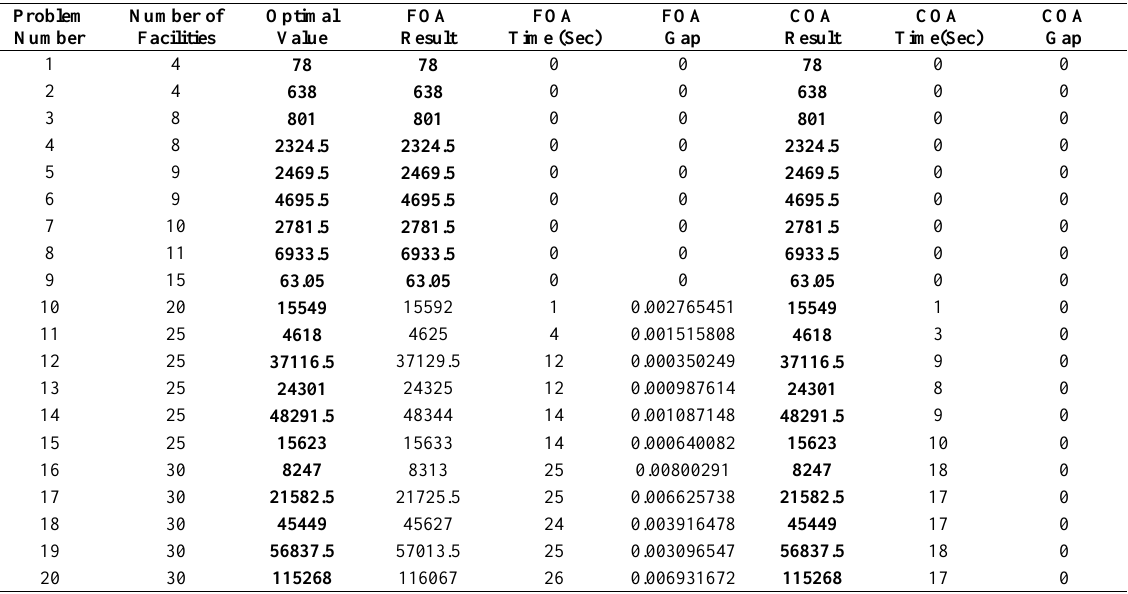
Table 1. Results for problem set1.